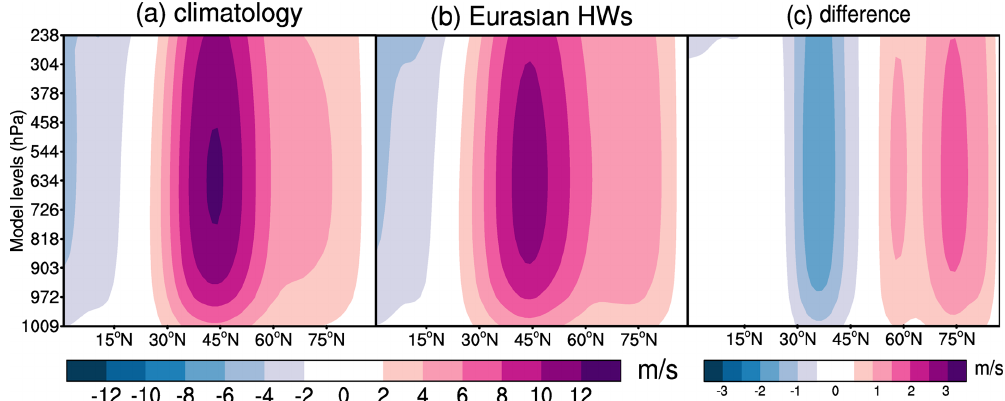
Figure 9. Zonal-mean zonal wind in the Northern Hemisphere troposphere in 1980–2019, May–September ERA5 data. (a) Climatology, (b) Eurasian heat waves (HWs) and (c) climatology –